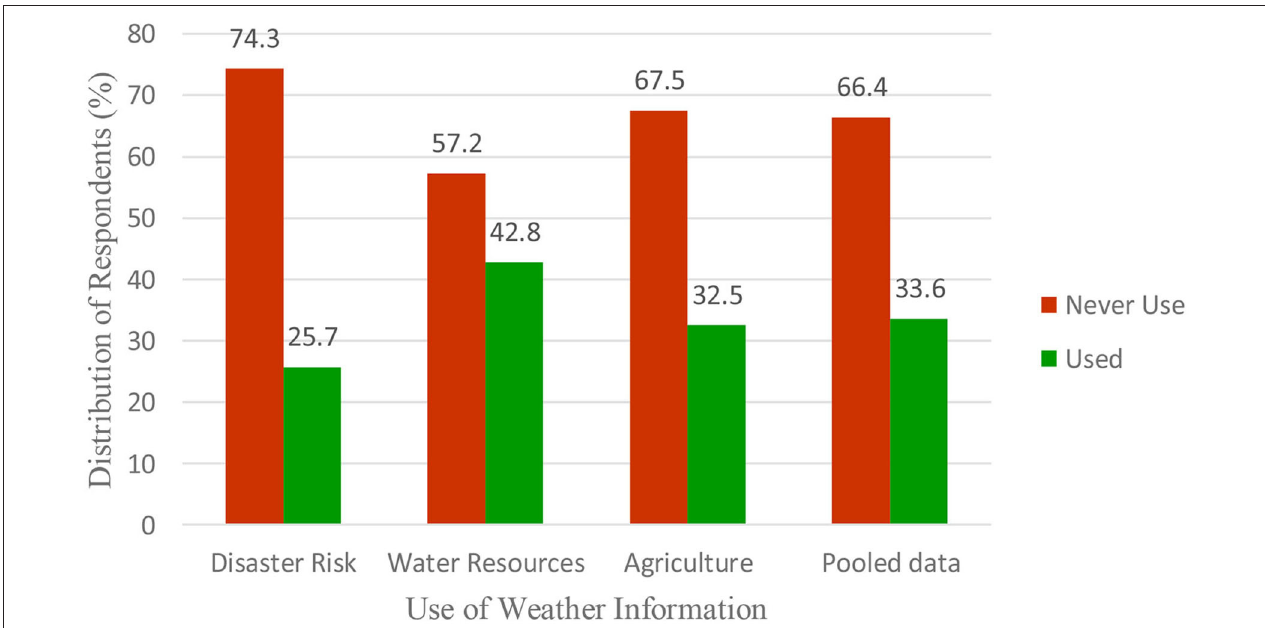
FIGURE 3 | Distribution of users and non-users of WCI for drought hazard preparedness.